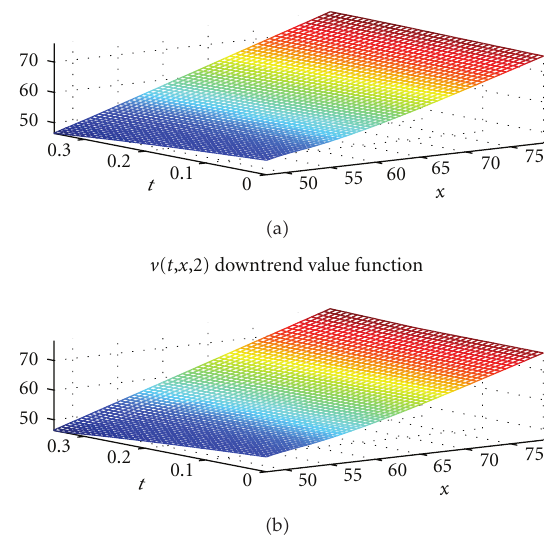
Figure 1: Value functions v (cid:5) t,x, 1 (cid:6) for the uptrend and v (cid:5) t,x, 2 (cid:6) for the downtrend.